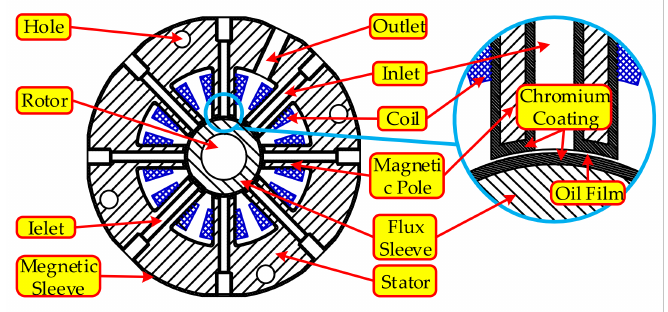
Figure 4. Structure of the radial